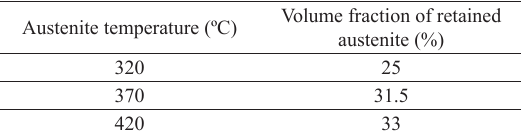
Table 1. Variation of amount of retained austenite with austempering